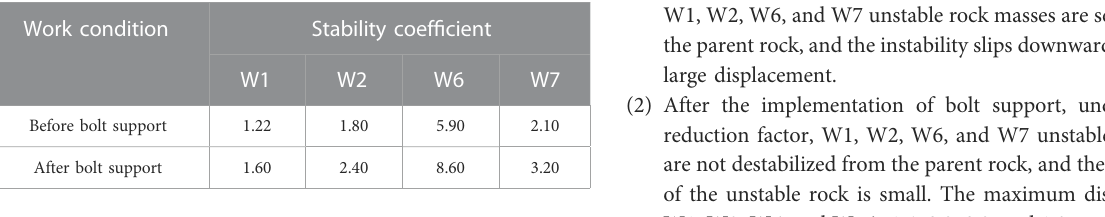
TABLE 7 Comparison of the slip stability coef fi cients of unstable rock. Work